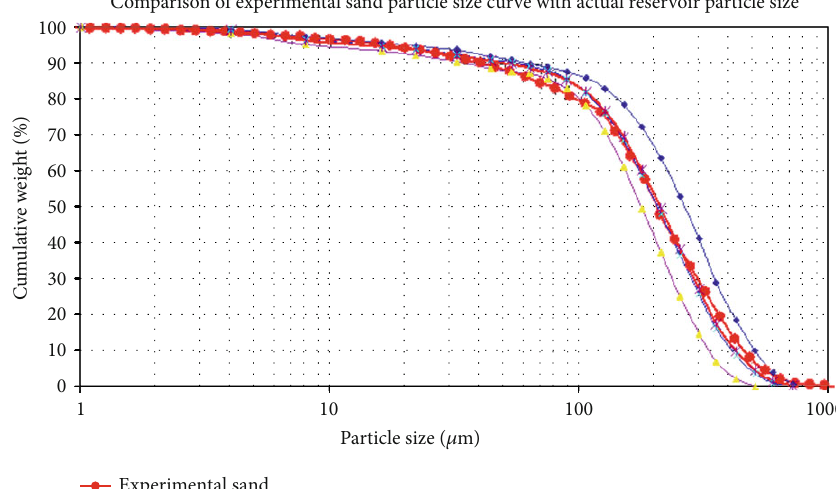
Figure 5: PSD comparison between the experimental sand and the reservoir.